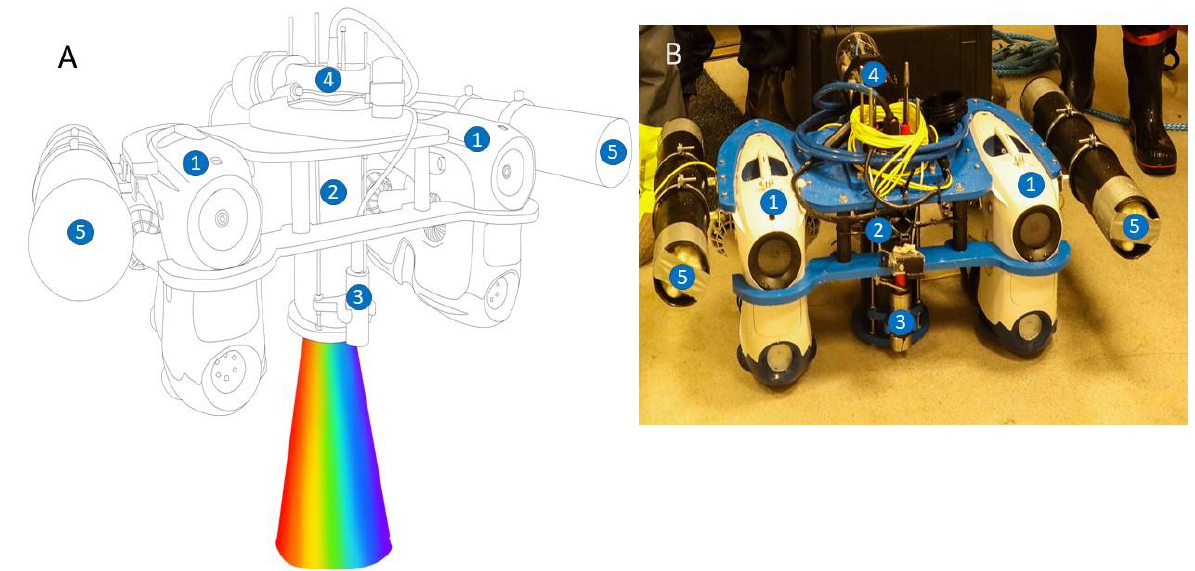
Figure 2. ( A ) Schematic front view of the double mini-ROV rig used (Blueye Pioneer, Blueye), as a carrier for an Underwater Hyperspectral Imager (UHI-4, Ecotone). 1. Mini-ROV, 2. UHI, 3. Altimeter, 4. Underwater electronic housing, 5. Buoyancy tubes (PVC tubes filled with incompressible foam). ( B ) Front view of the mini-ROV rig. Credits: ( A ) by Malin Bø Nevstad, ( B ) by Geir Johnsen.